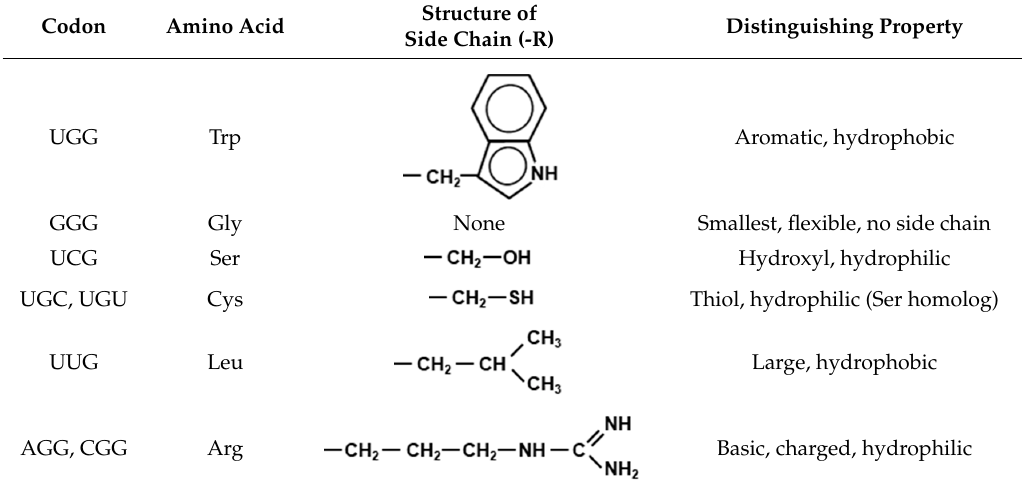
Table 1. Codons that di ff er from the Trp codon in the third (wobble) base.